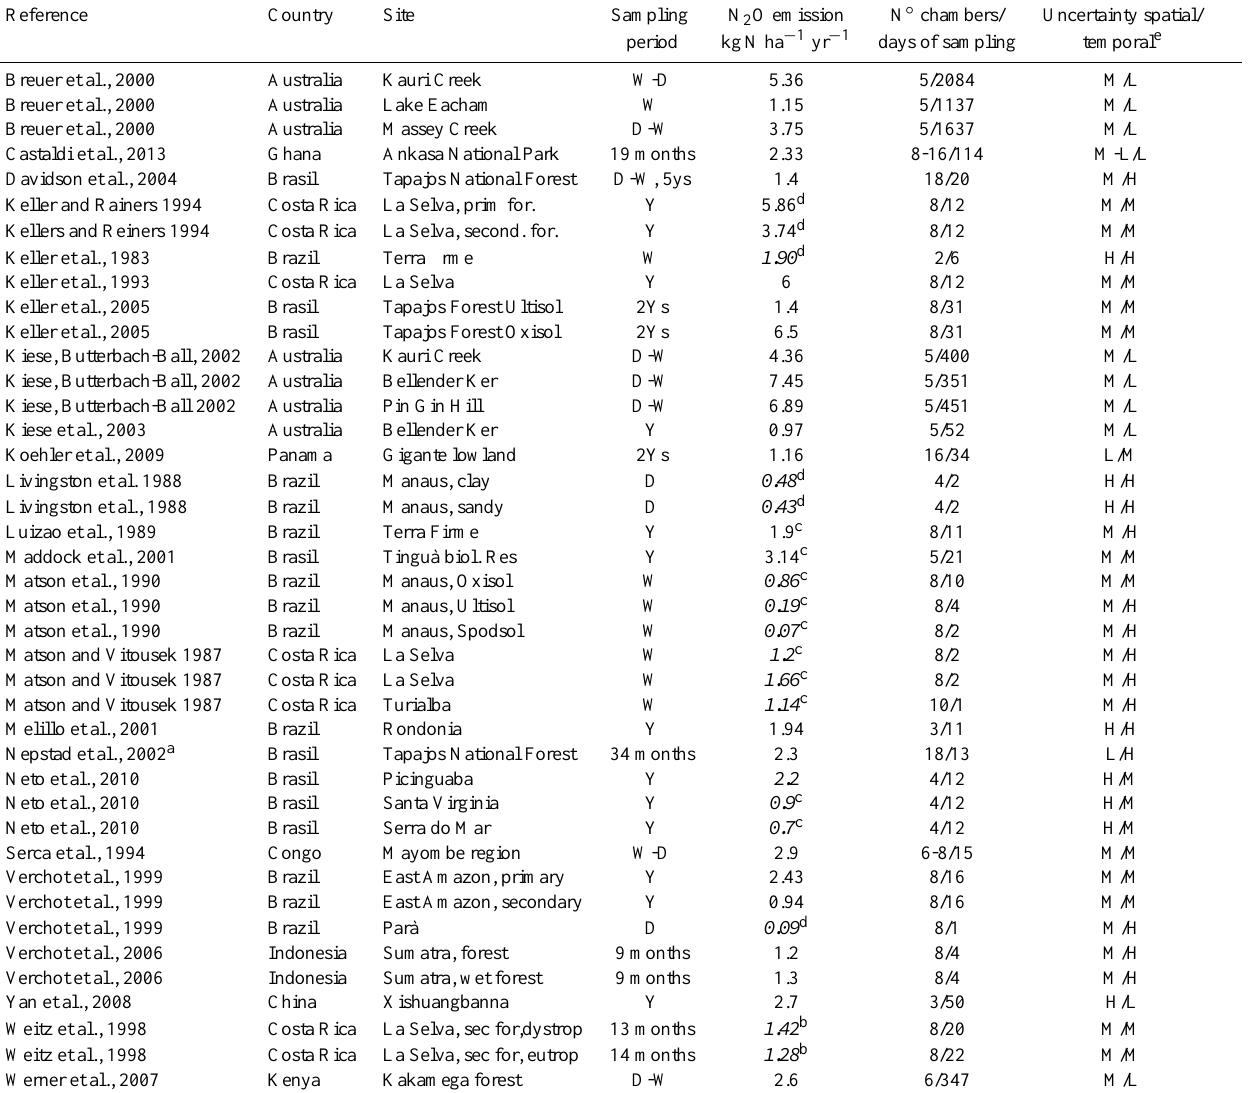
Table 2. Annual or seasonal rates (italic) of N 2 O emission (kgNha − 1 yr − 1 ) as reported by authors or calculated (where indicated) from literature studies in humid tropical forests. Reported campaigns occurred only in dry (D) or wet (W) seasons; over a whole year (Y); during periods longer than one year (months are indicated). Arbitrary uncertainty levels are given (explained in Table notes) not as an absolute level of uncertainty but as a comparative indication among